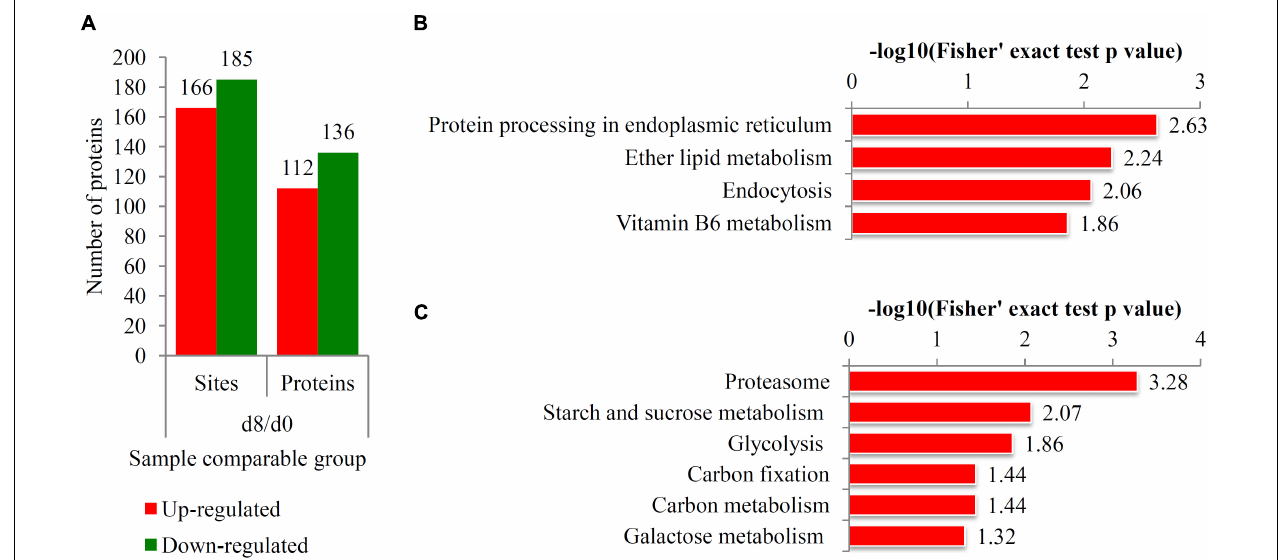
FIGURE 5 | Identification of differentially ubiquitinated proteins responsive to ripening process. (A) The number of up- and down-regulated ubiquitinated proteins during the fruit ripening process. Red bars indicated the up-regulated proteins and green bars indicated the down-regulated proteins. (B) KEGG analysis of the up-regulated ubiquitinated proteins. (C) KEGG analysis of the down-regulated ubiquitinated proteins. The negative logarithm of Fisher’s exact test P -value was showed in ×